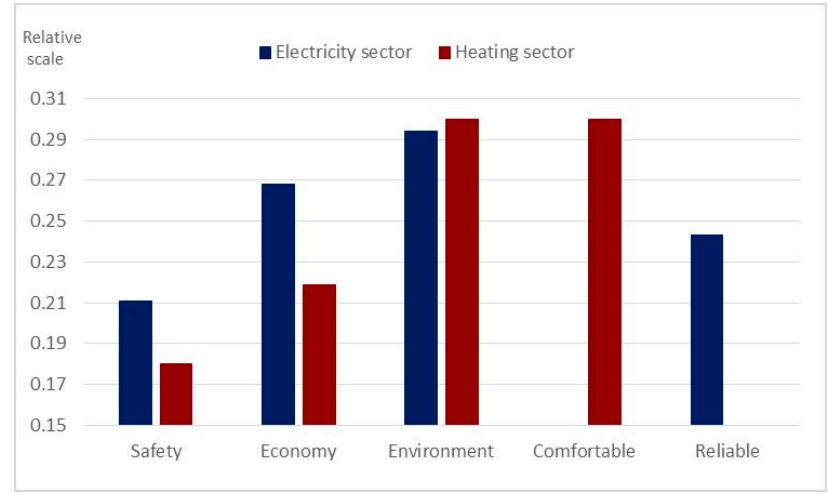
Figure 4. Aggregate normalized values of main criteria weights (four for each).